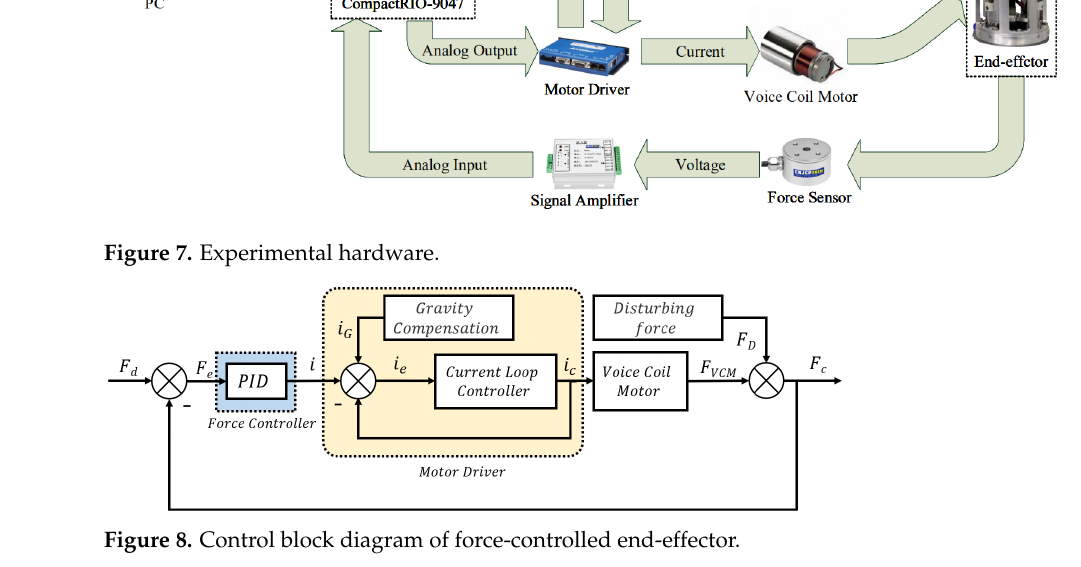
Figure 8. Control block diagram of force-controlled end-effector.